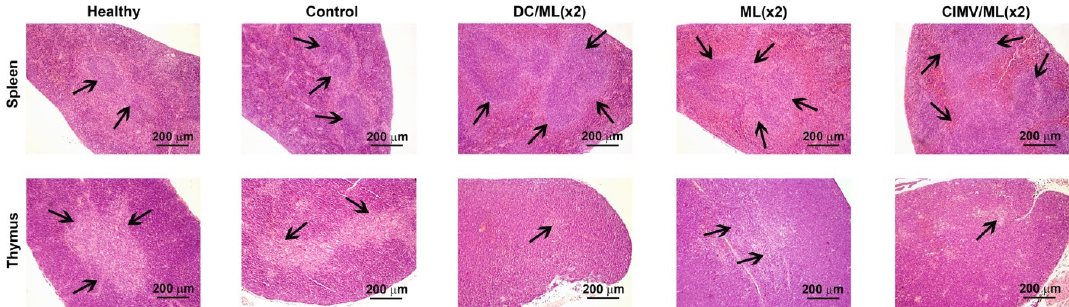
Figure 5. Immunomodulatory effects of vaccines in RLS 40 -bearing mice. Representative histological images of the spleen ( upper panel ) and thymus ( bottom panel ) sections. Hematoxylin and eosin staining. Black arrows indicate lymphoid follicles in the spleen ( upper panel ) and medulla in the thymus ( bottom panel ). Original magnification ×